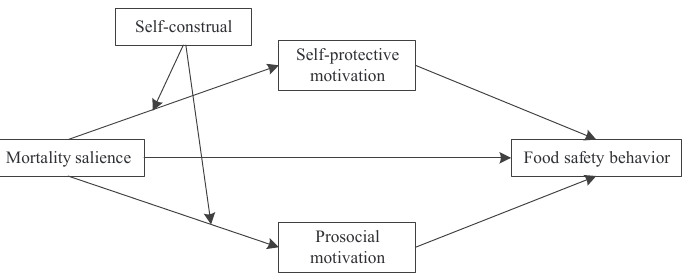
Figure 1. The conceptual framework.